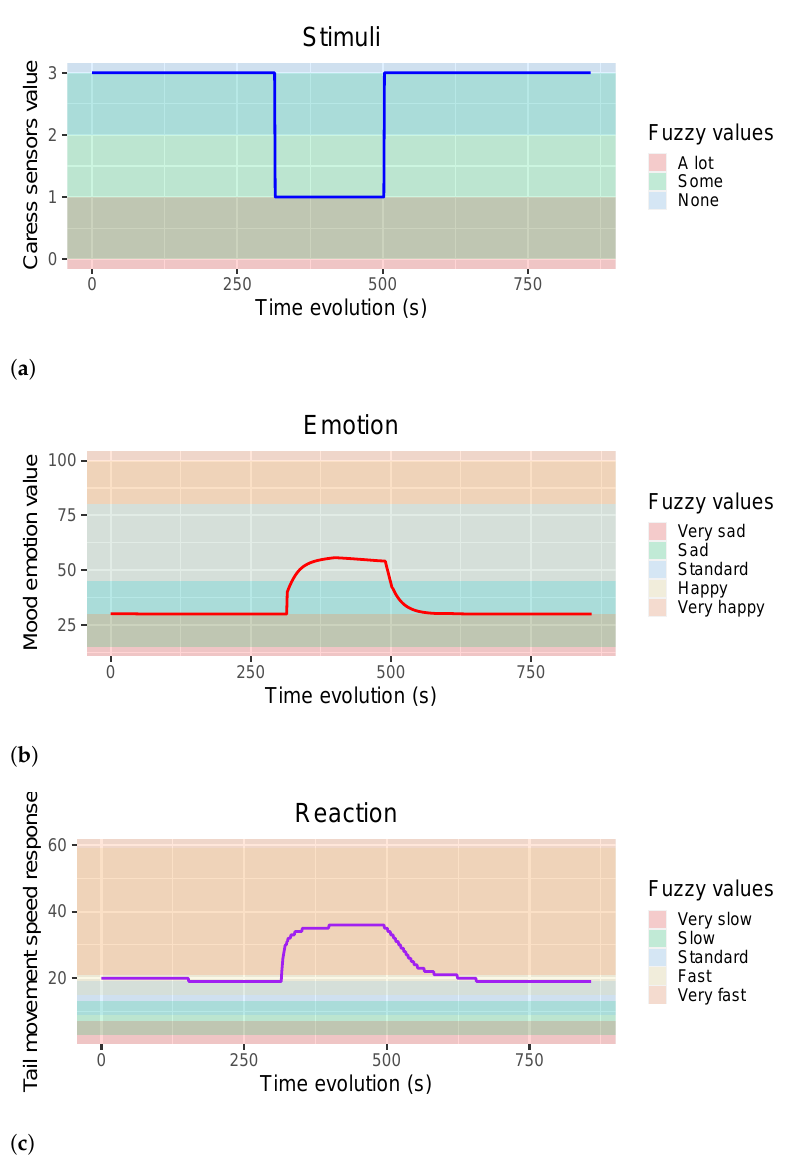
Figure 13. Experiment two results. ( a ) Caress-sensors’ values. ( b ) MOOD emotion in function of the caress stimuli. ( c ) Tail movement speed in function of the emotional